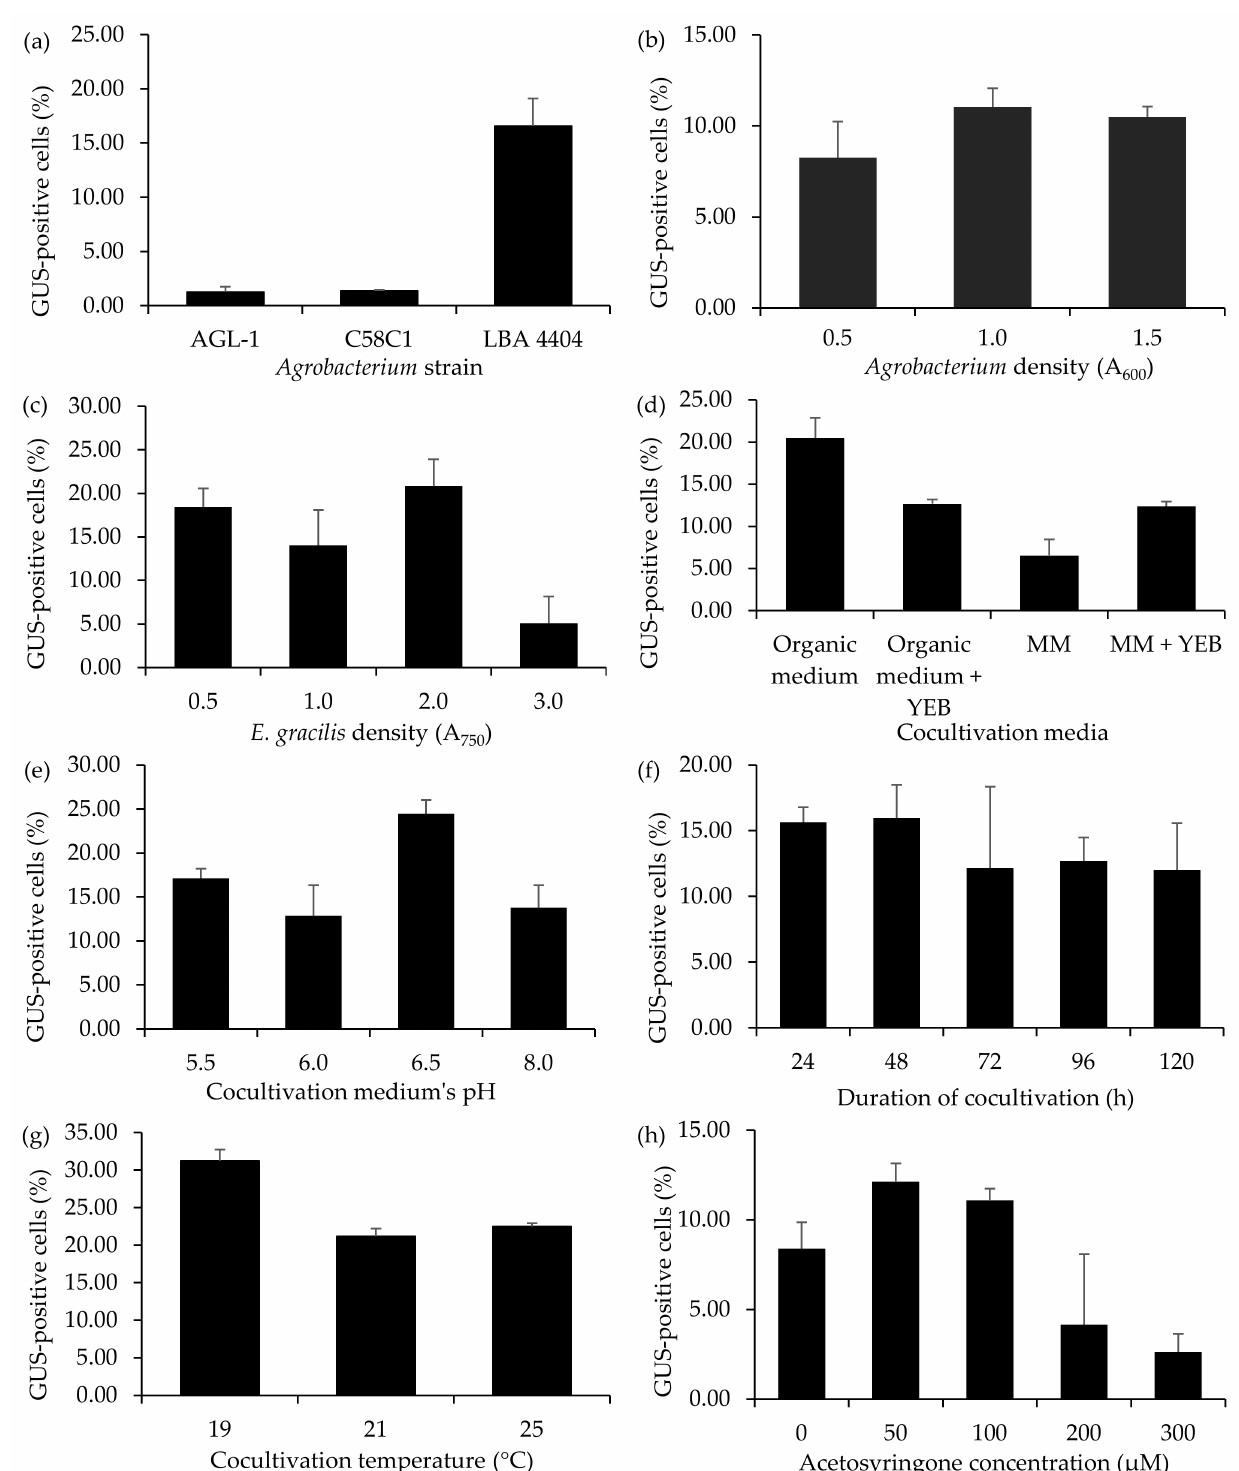
Figure 6. The effects of different cocultivation parameters on ATMT of E. gracilis . ( a ) A. tumefaciens strain; ( b ) Agrobacterium concentration; ( c ) E. gracilis concentration; ( d ) cocultivation media; ( e ) pH of the cocultivation medium; ( f ) cocultivation duration; ( g ) cocultivation temperature; ( h ) acetosyringone concentration. The values are the means ± standard deviation of three independent